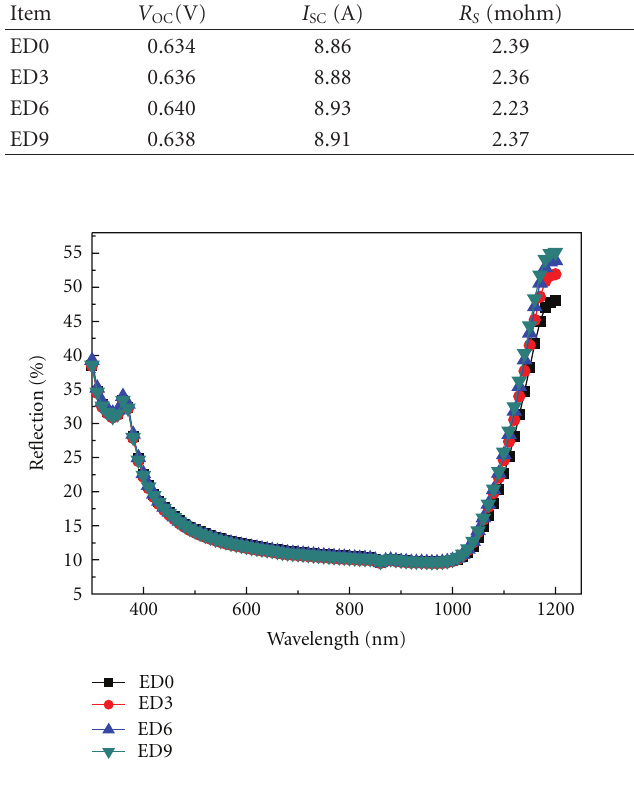
Figure 5: Comparison of reflectivity of four di ff erent etching depths after